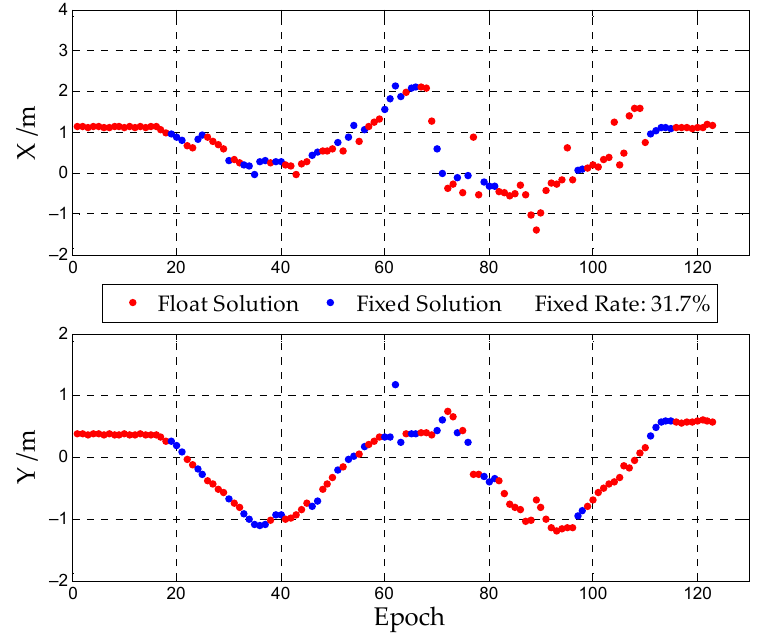
Figure 11. Results in X, Y Components of Experiment 2.